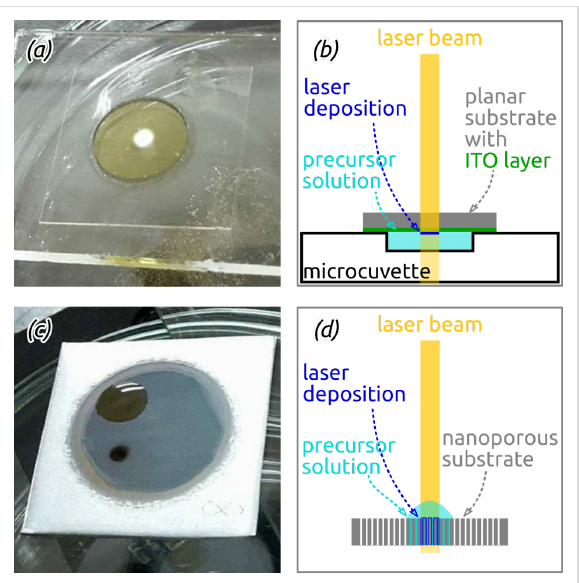
Figure 5: Preparation of nanostructured Ru/C electrodes. (a) Anodiza- tion of Al in 1 wt % H 3 PO 4 ; this step defines the pore length L . (b) Removal of the Al substrate and Al 2 O 3 barrier layer with simulta- neous pore widening. (c) Laser-induced Ru/C decoration of